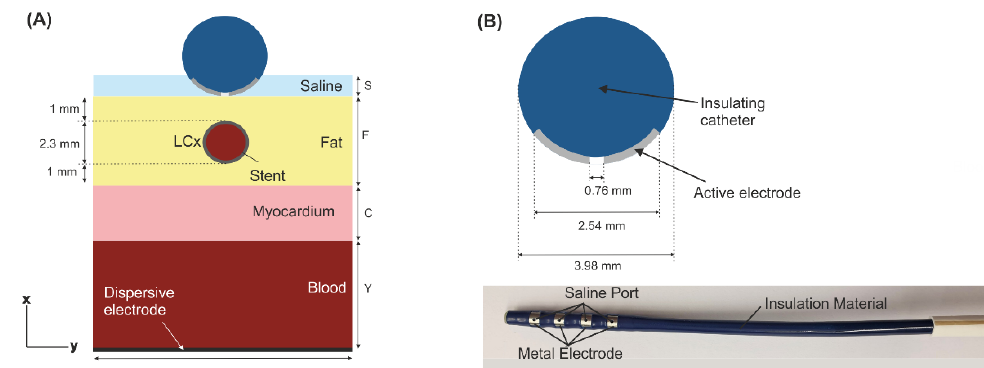
Figure 1. Physical situation modelled in the study. Anatomical picture ( A ) and histological image ( B ) showing the spatial relation between the ablation electrode and the left circumflex coronary ar- tery –LCx–.Reprinted adapted with permission from [10]. Copyright © 2014 Damián Sánchez-Quin- tana et al. (it is an open access article distributed under the Creative Commons Attribution License (Attribution 3.0 Unported (CC BY 3.0)).